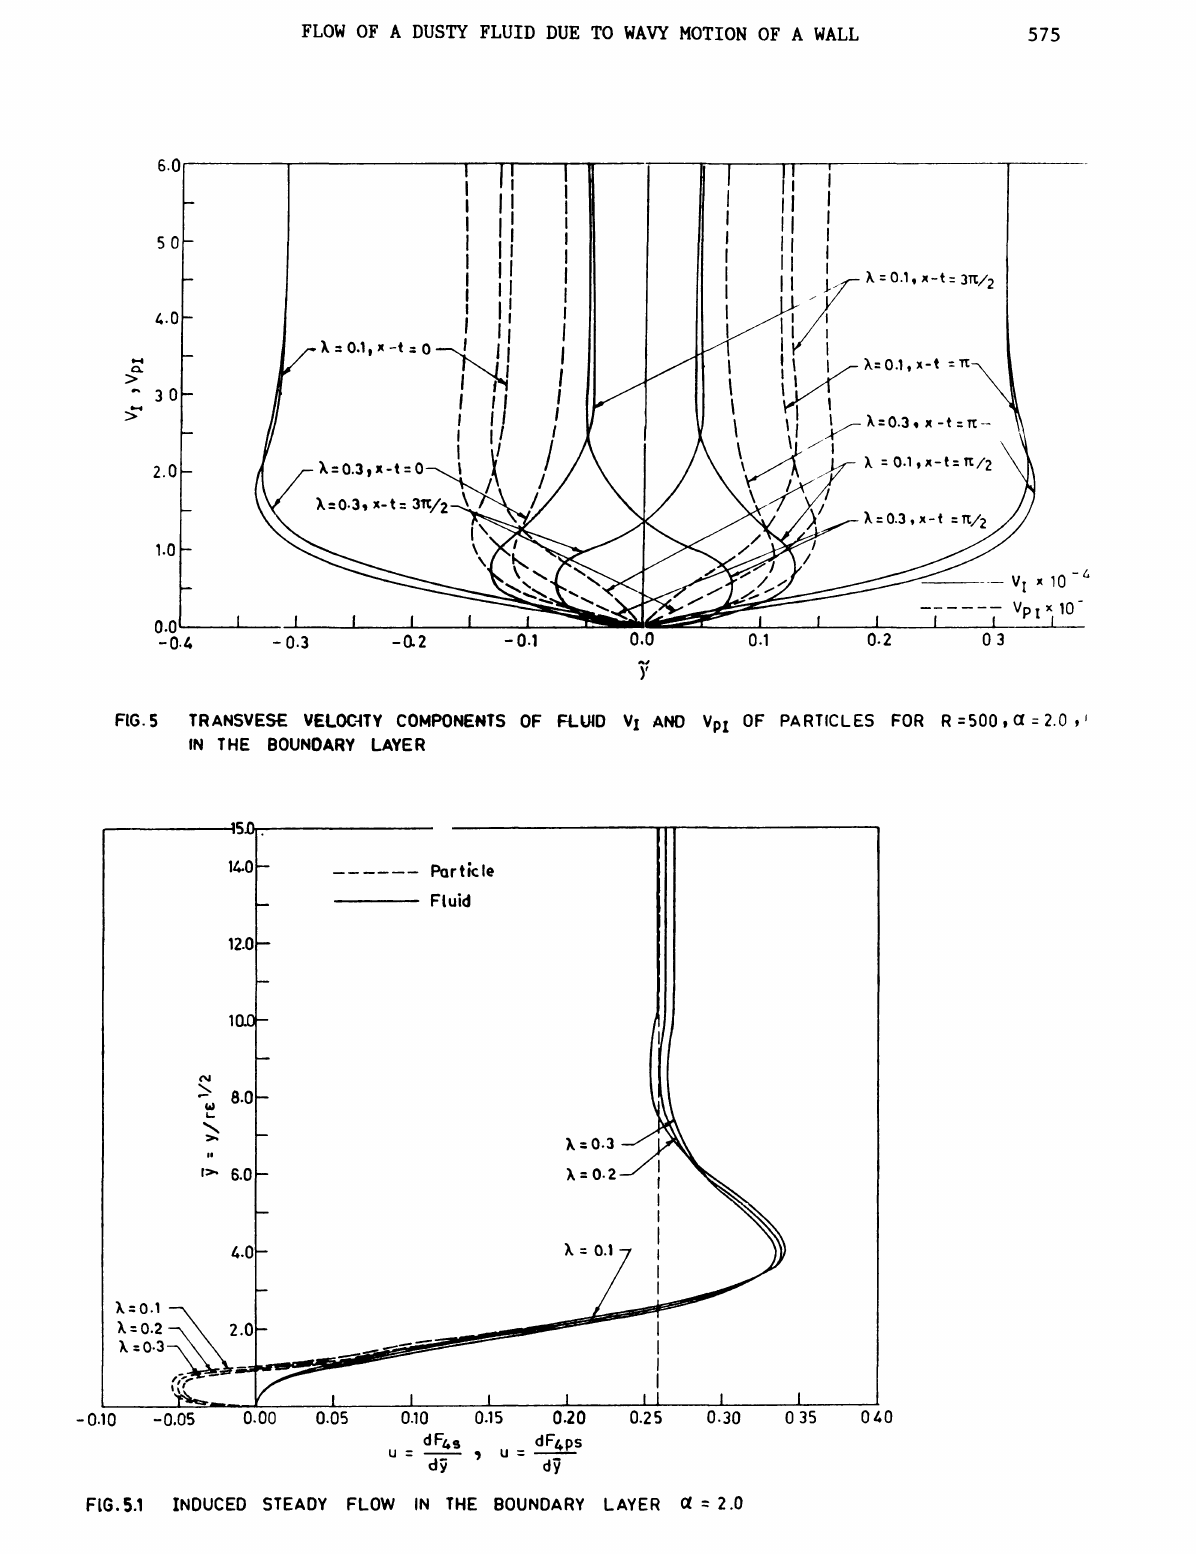
INDUCED STEADY FLOW IN THE BOUNDARY LAYER